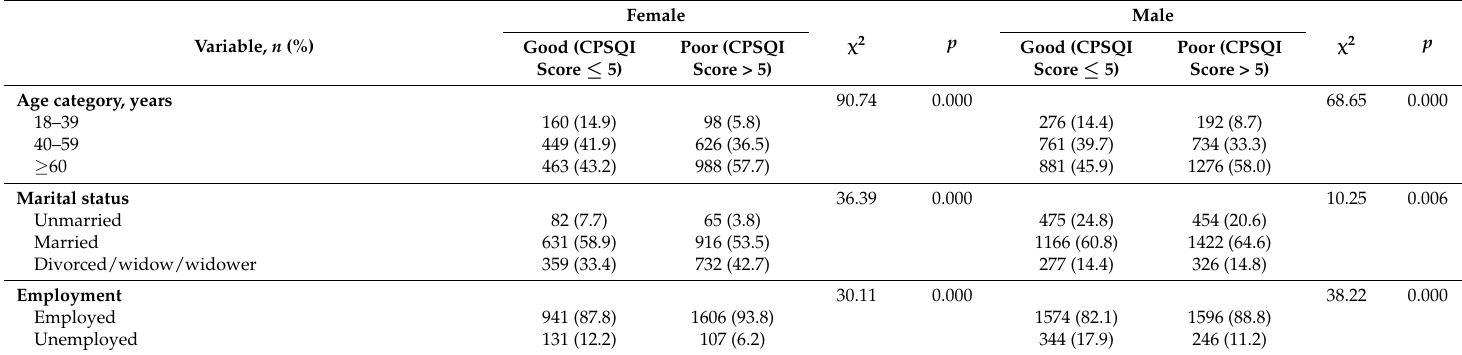
Table 2. Characteristics affecting quality of sleep by